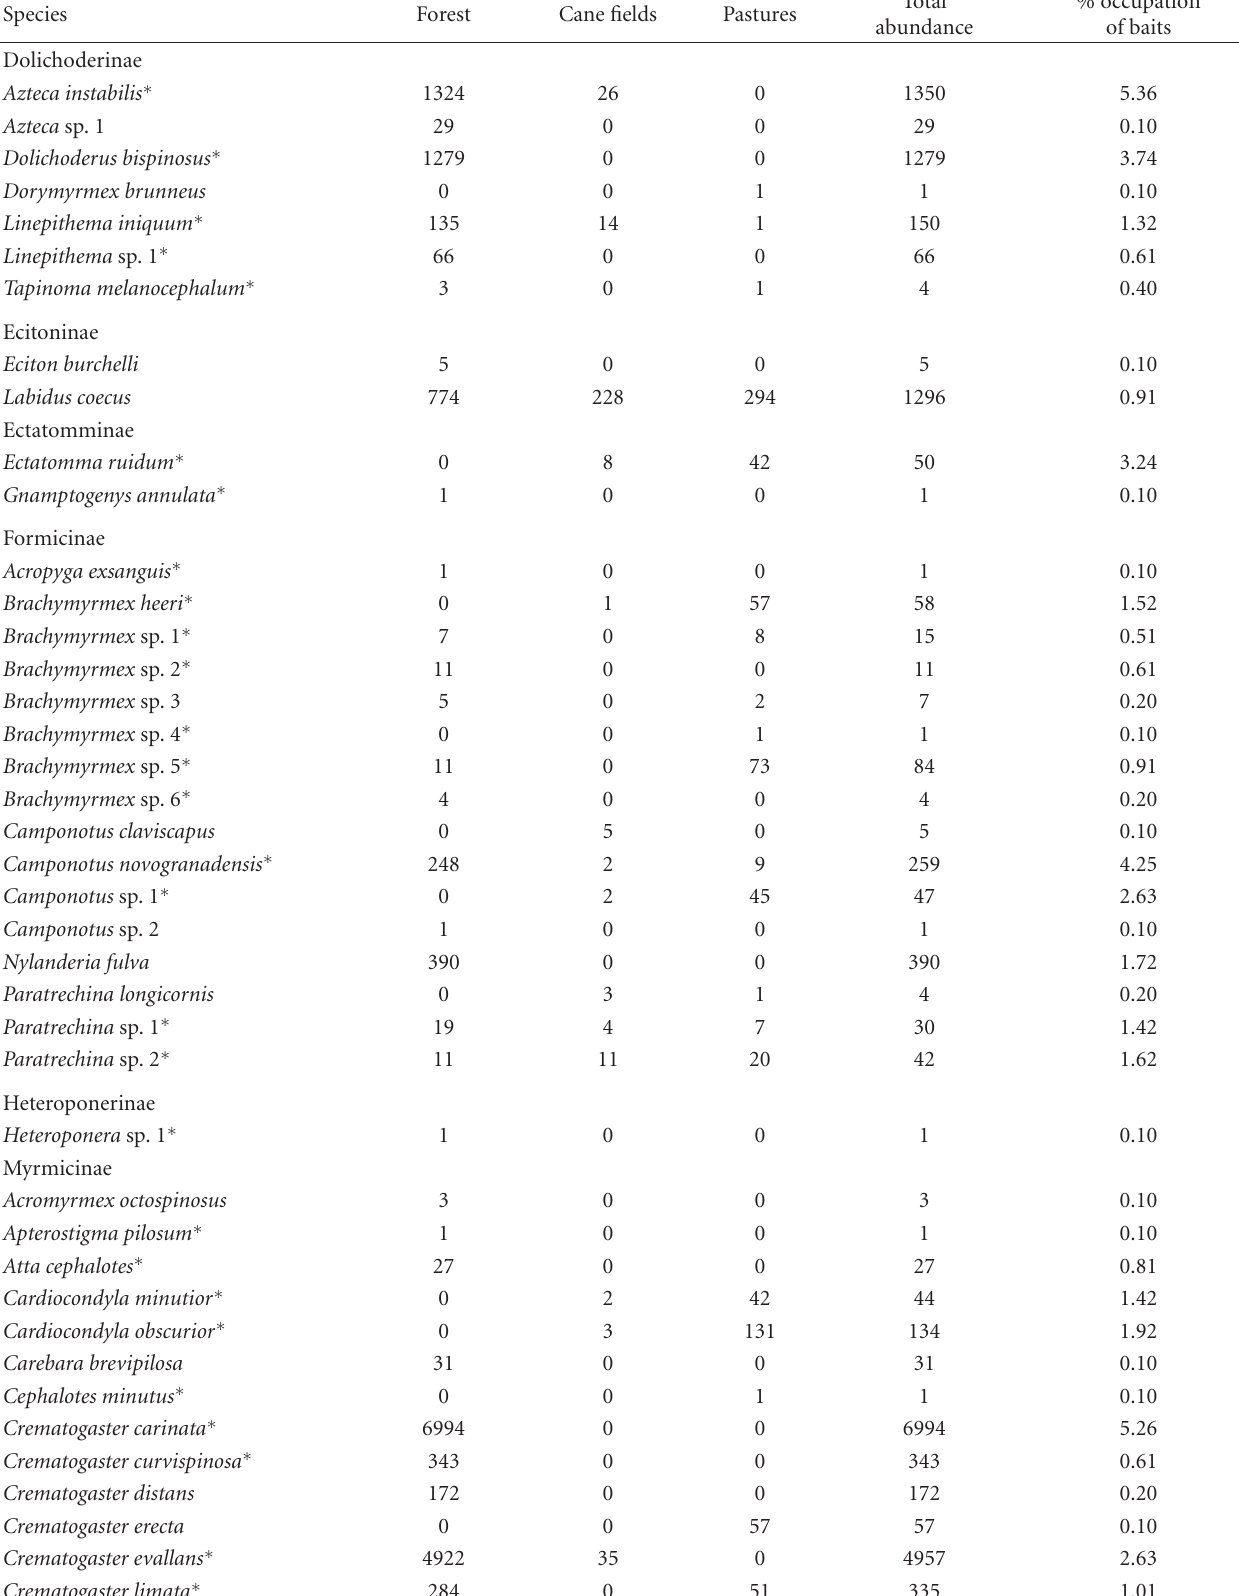
Table 4: List of ant species sampled and their abundance at baits along a tropical dry forest region of southwestern Colombia. Species Forest Cane fields Pastures